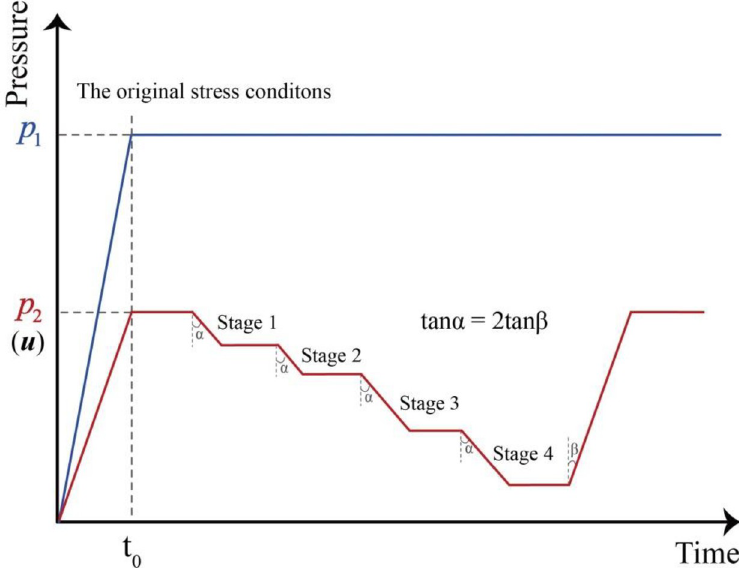
Fig 5. Schematic diagram of the test design, P 1 represents the total stress acting on the samples in the original strata, and P 2 represents the pore water pressure ( u ) inside the sample. Four stages of reducing pore water pressure are designed in the